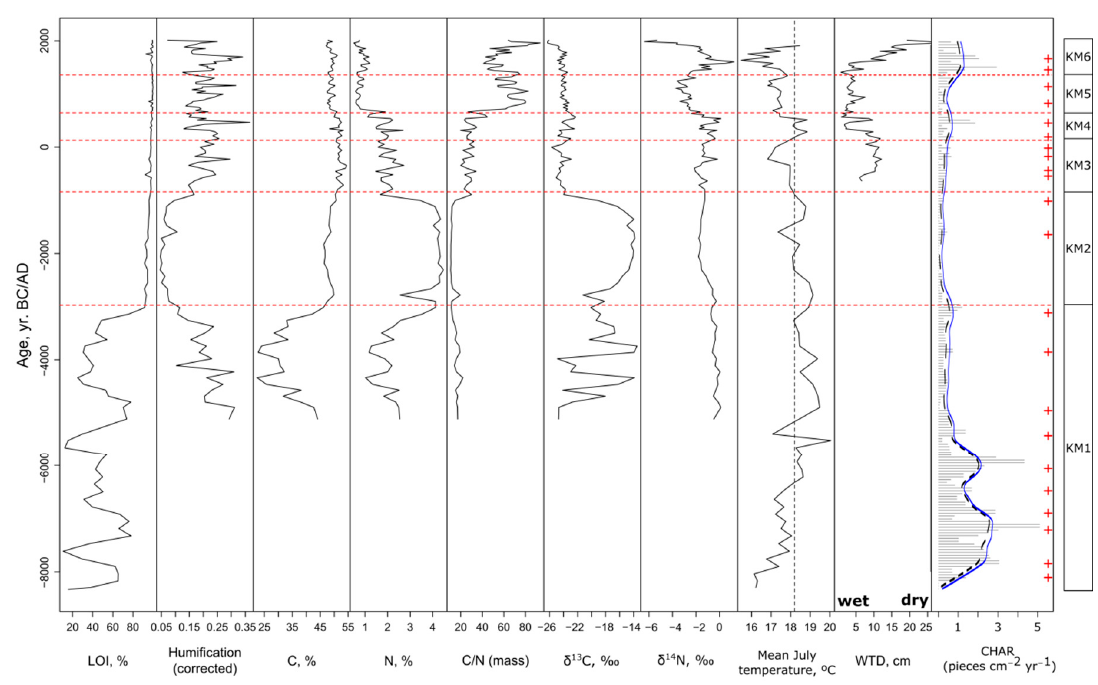
Figure 4. Peat properties of the deposits of the Krivetskiy Mokh mire (loss on ignition (LOI), %; peat humification, measured as light absorbance corrected for LOI; carbon content, %; nitrogen content, %; C:N ratio; δ 13 C, ‰, and δ 15 N, ‰); reconstructed mean July temperature (° С , pollen-based), mire surface wetness (as water table depth, WTD cm; greater values denote drier conditions; testate amoeba-based) and charcoal accumulation rates (CHAR; grey bars—interpolated CHAR, dotted black line—background charcoal, blue line—threshold values, red crosses—local fire episodes). The red dashed lines separate six zones (KM1–KM6) defined based on the main developmental stages of the mire. The vertical grey dashed line marks the present-day mean July temperature in the region for the period 1989–2018.